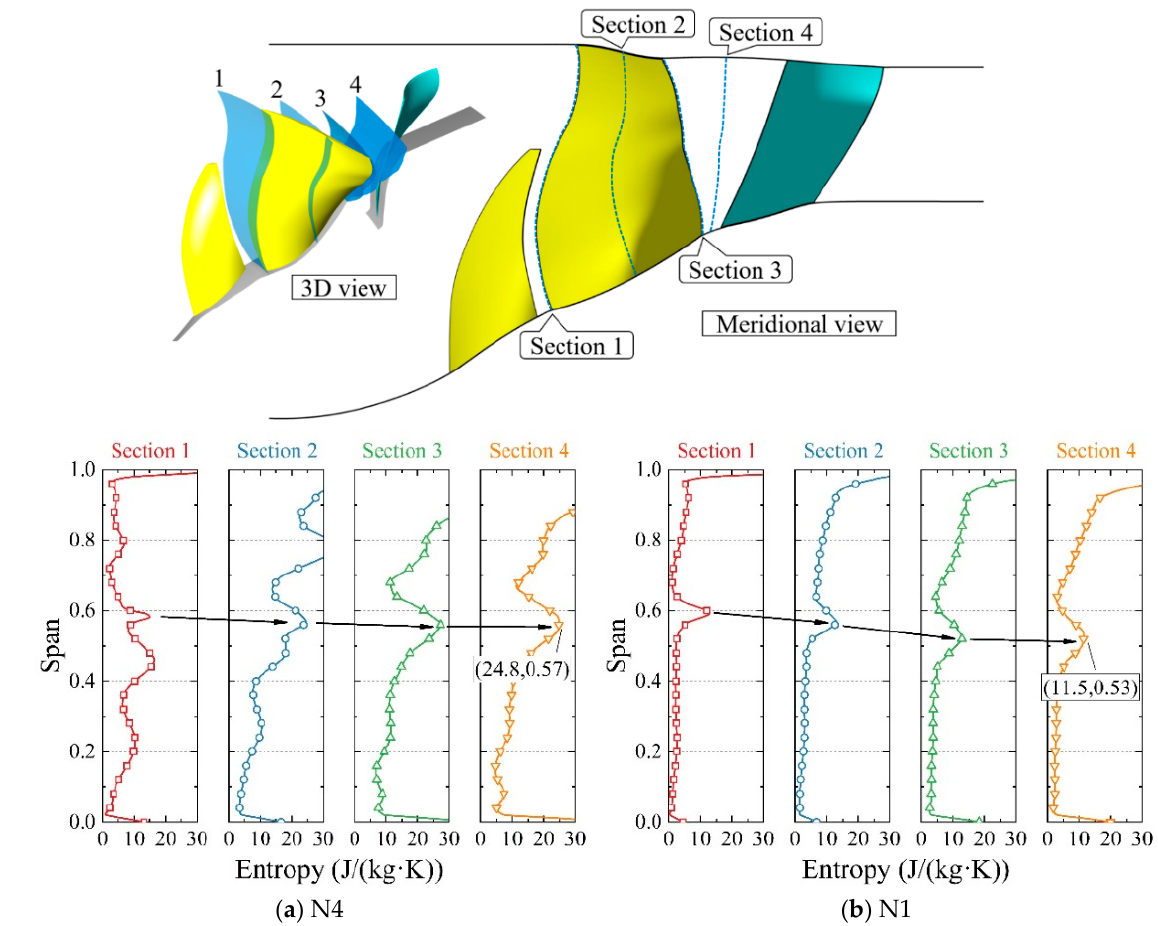
Figure 21. Spanwise distribution of the entropy at N4 and N1 of the tandem rotor.